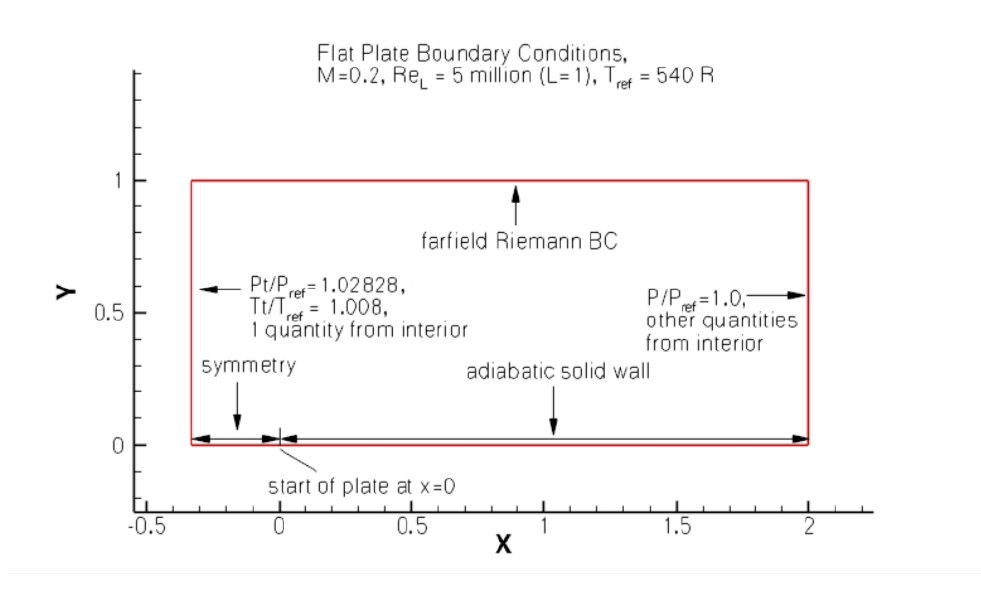
Figure 1. Flat plate boundary conditions [20].